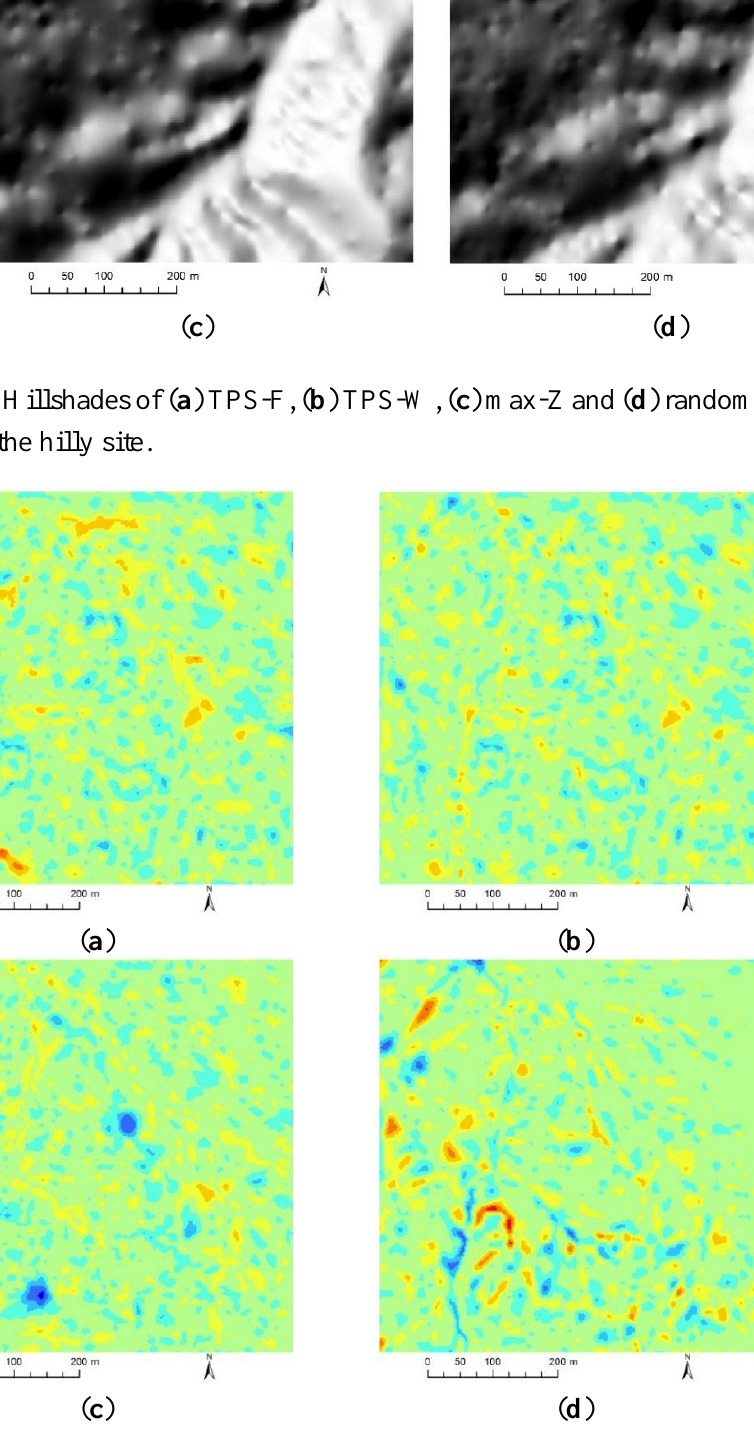
Figure 9. Error maps of ( a ) TPS-F, ( b ) TPS-W, ( c ) max-Z and ( d ) random with1% of LiDAR points in the undulating